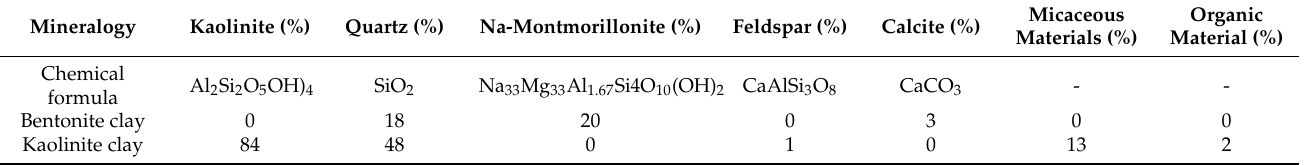
Table 3. Mineralogical composition of bentonite and